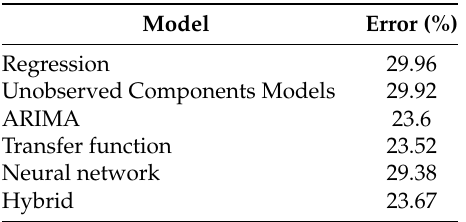
Table 3. Comparison of forecast errors from Reikard